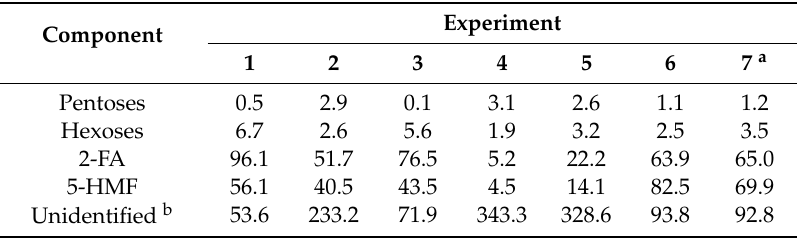
Table 3. Yield (g · kg − 1 ) of chosen components contained in the WS fractions obtained from hydrothermolysis of pectin free sugar beet pulp.